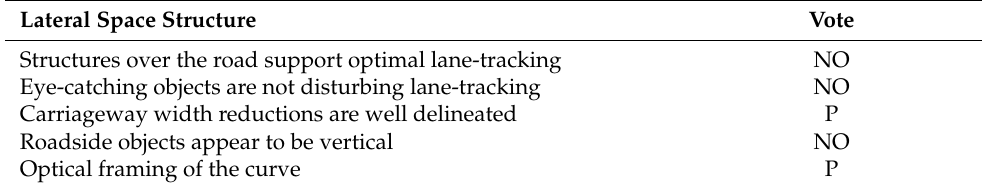
Table 8. Evaluations of the “lateral space structure” investigation topic. Lateral Space